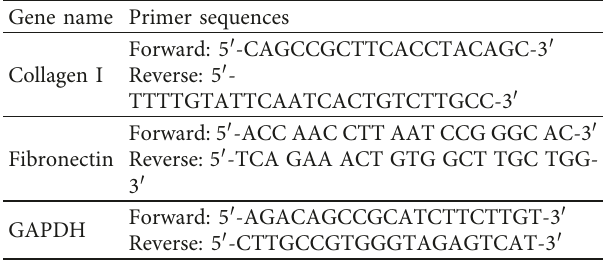
Table 1: Primers used in real-time polymerase chain reaction. Gene name Primer